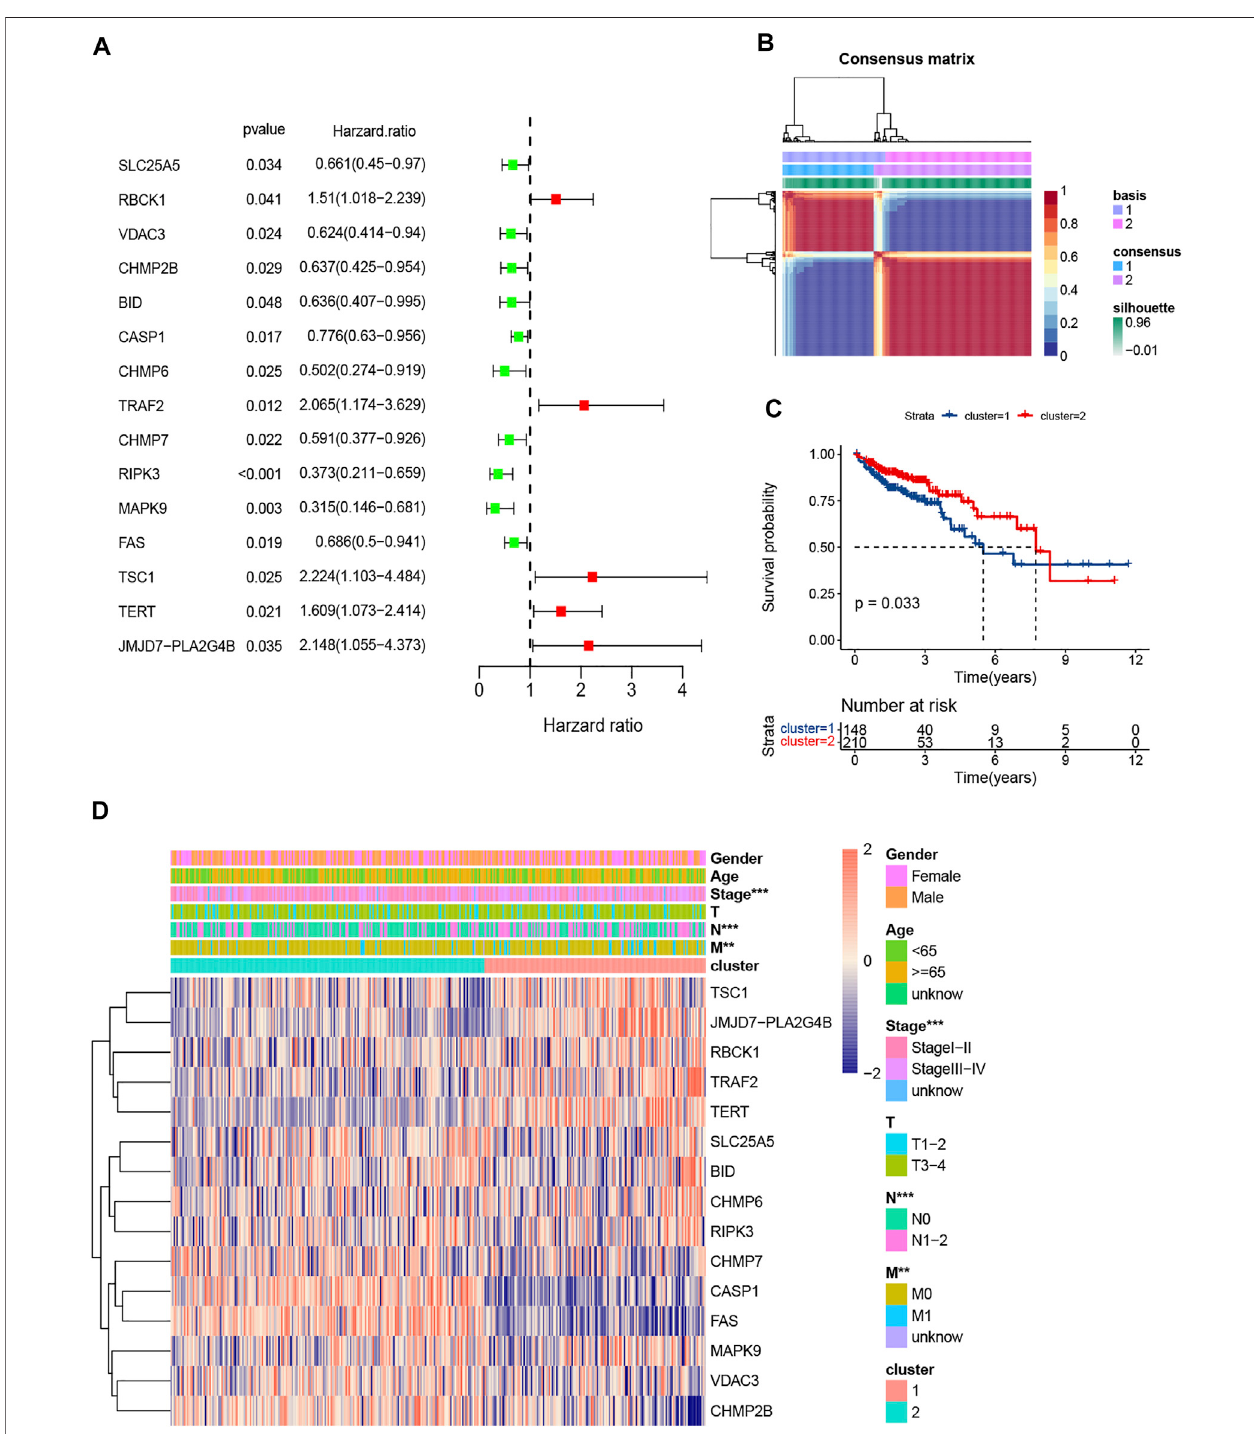
FIGURE 2 | Screening of prognosis-related NRGs by univariate Cox and clustering by nonnegative matrix factorization (NMF). (A). The forest plot of 15 prognosis- related NRGs ( p < 0.05); (B). Colorectal cancer samples were clustered by NMF method; (C). Survival analysis of two clusters; (D). Heatmap and clinicopathologic features of Clusters 1 and